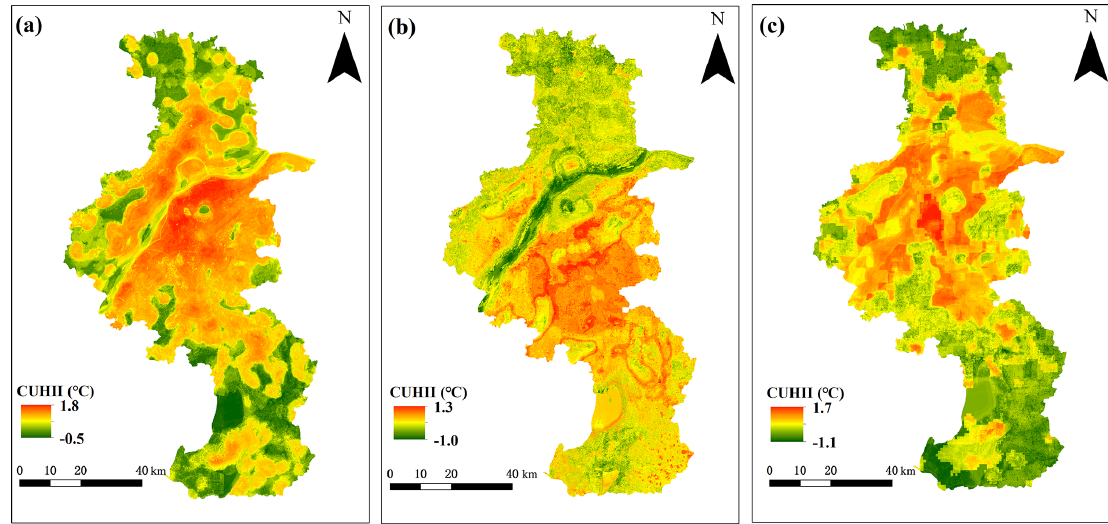
Figure 10. Spatial distribution of the CUHII in Nanjing: (a) 11 August 2013; (b) 2 September 2015; (c) 21 July 2017. Table 5. Area occupied by different levels of urban heat island intensity on different days (km 2 ). Date format: dd/mm/yyyy. CUHII level ( ◦ C) − 1 . 5 to −